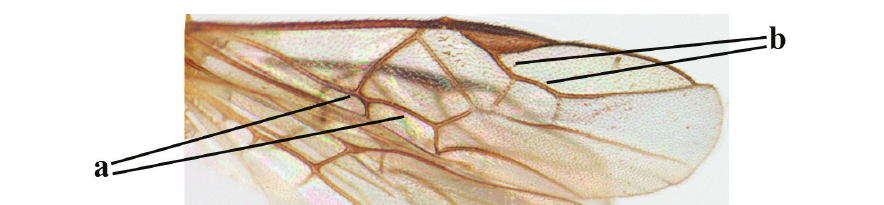
Vein M+CU1 of fore wing apically at about same level as vein 2-CU1 (a); vein r of fore wing 0.6–0.9 × vein 3-SR (b); length of fore wing 3.4–3.7 mm;